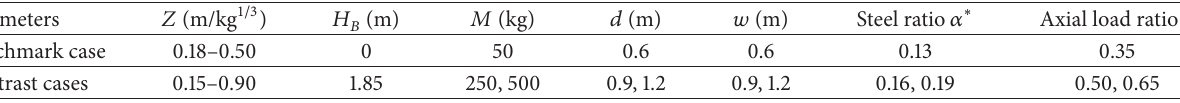
Table 4: Parameters used in the numerical parametric study.